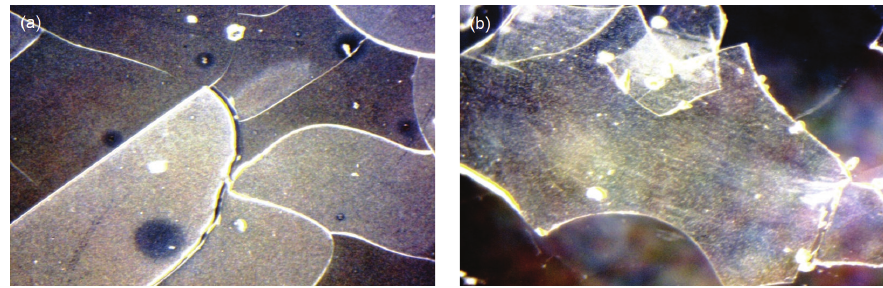
Figure 4: The 500x magnification of the coating surface of coatings from sample (a) 20N and (b) 20E.